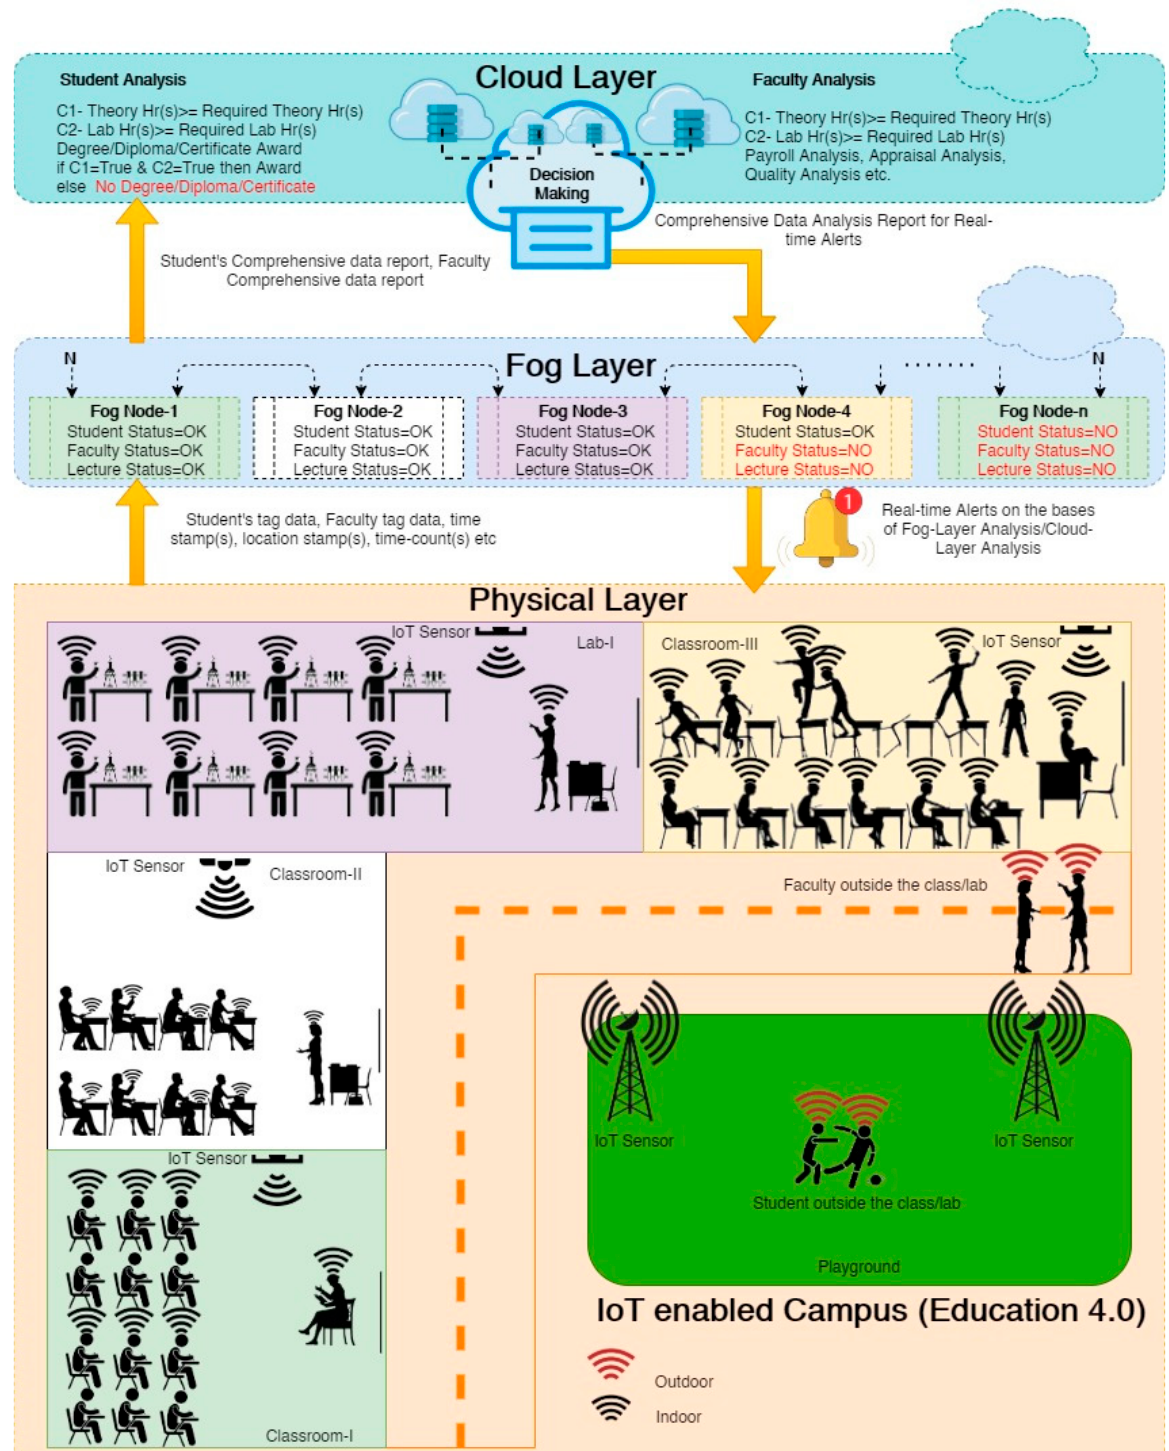
Figure 1. The proposed layered architecture for assessment and irregularity detection for the ambient education environment under Education 4.0.